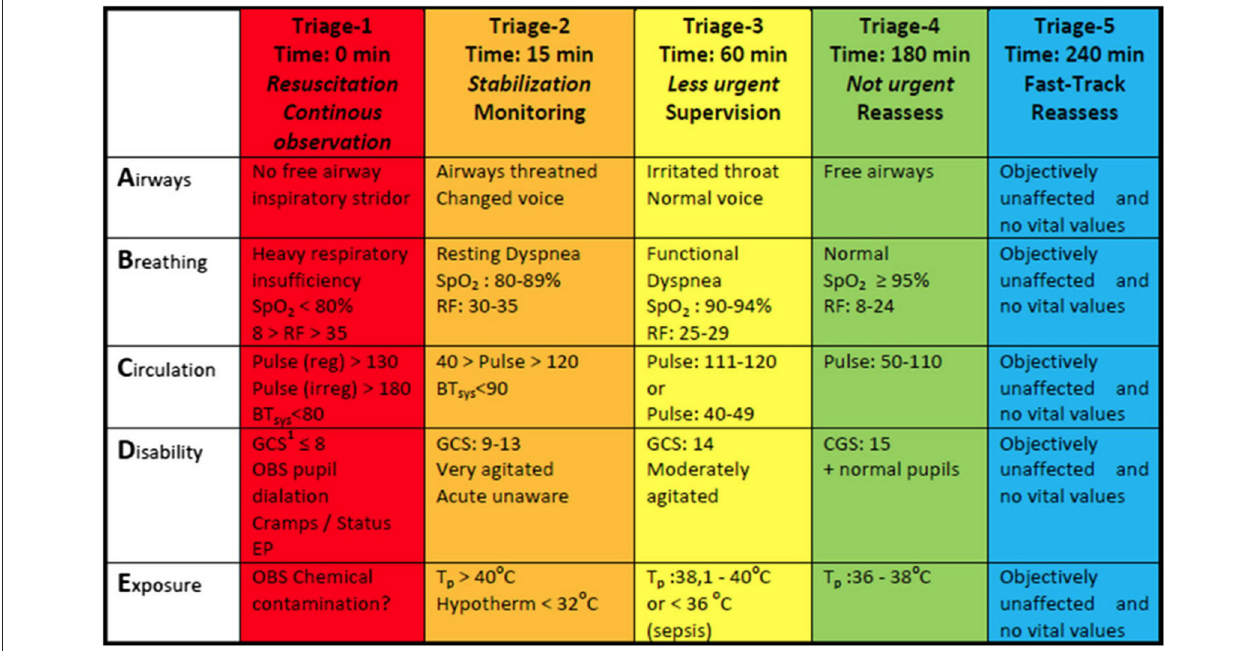
FIGURE 1 | Overview of the parameters that are used to triage the patients (Schmidt and Wiil,